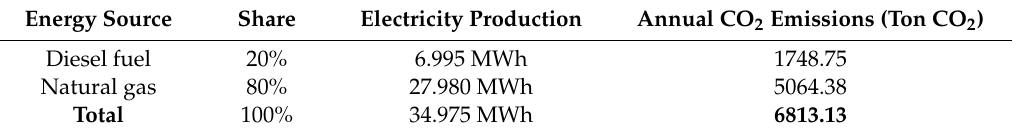
Table 11. Annualcarbondioxideemissionsfromdieselandnaturalgasfor34.976MWhelectricitygeneration. Energy